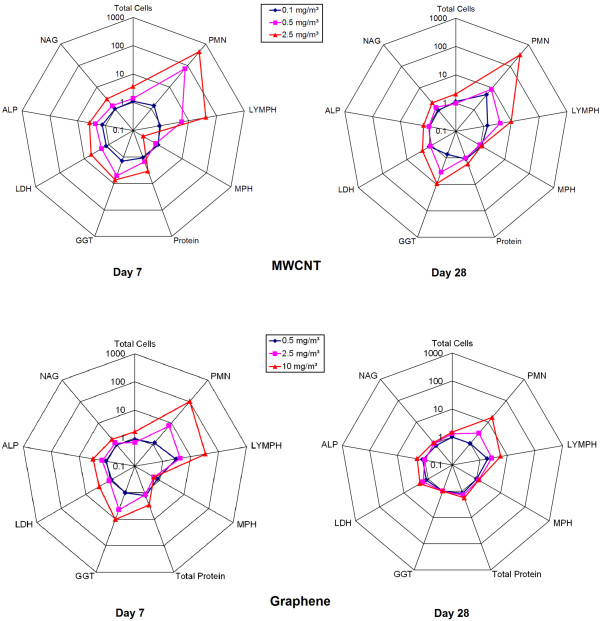
Comparison of changes in BALF parameters after exposure to MWCNT and graphene. Changes are shown as x-fold differences compared to controls using a logarithmic scaling.